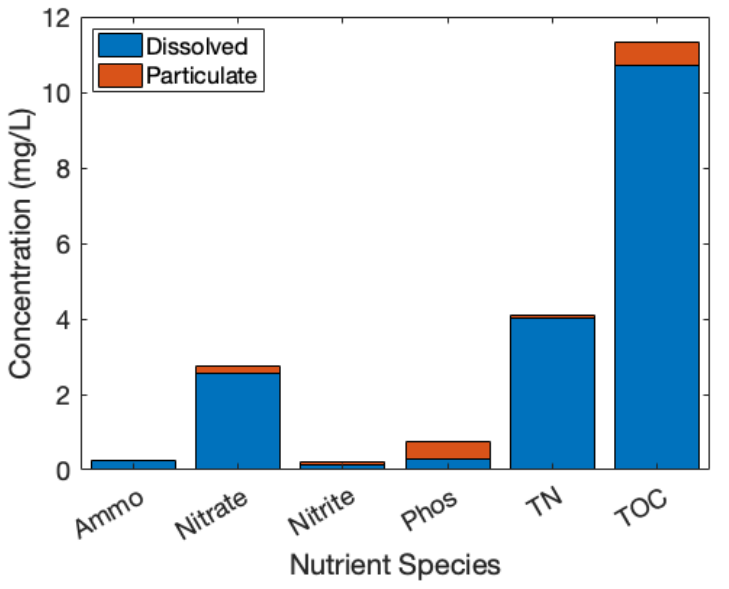
Figure A8. Distribution bar plot of dissolved and particulate associated nutrient concentrations.